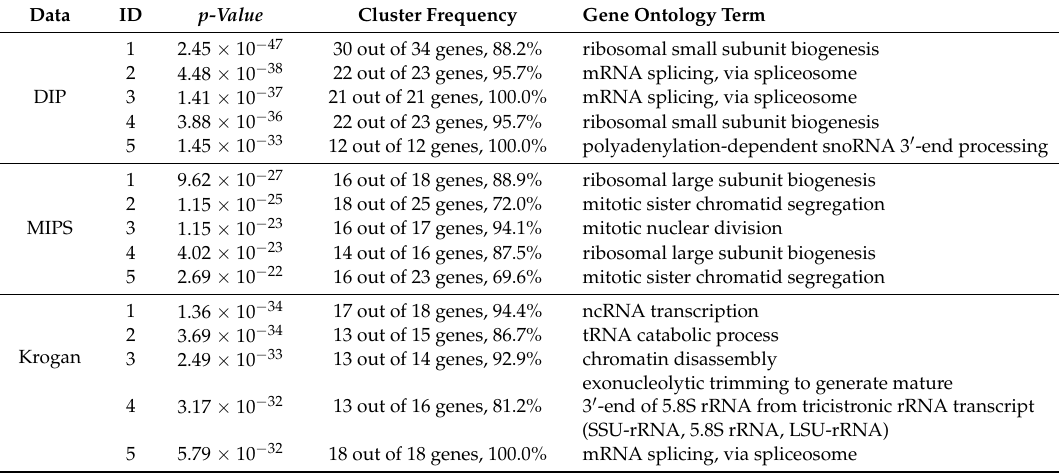
Table 3. Predicted protein complexes with small p-values on different